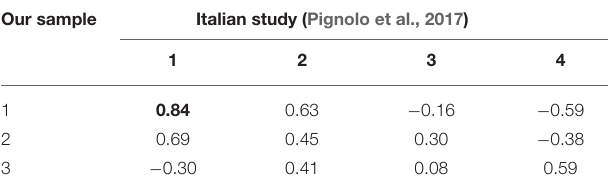
TABLE 9 | Coefficients of congruence ( 8 ) between factors of our sample and factors based on linearly independent scales of Italian study. Our sample Italian study (Pignolo et al., 2017)